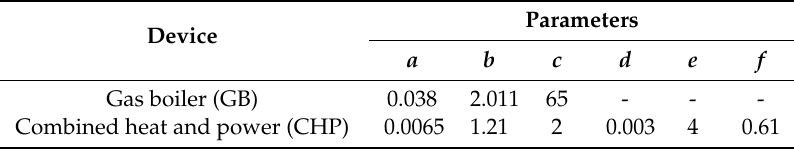
Table 5. Parameters of operating cost.